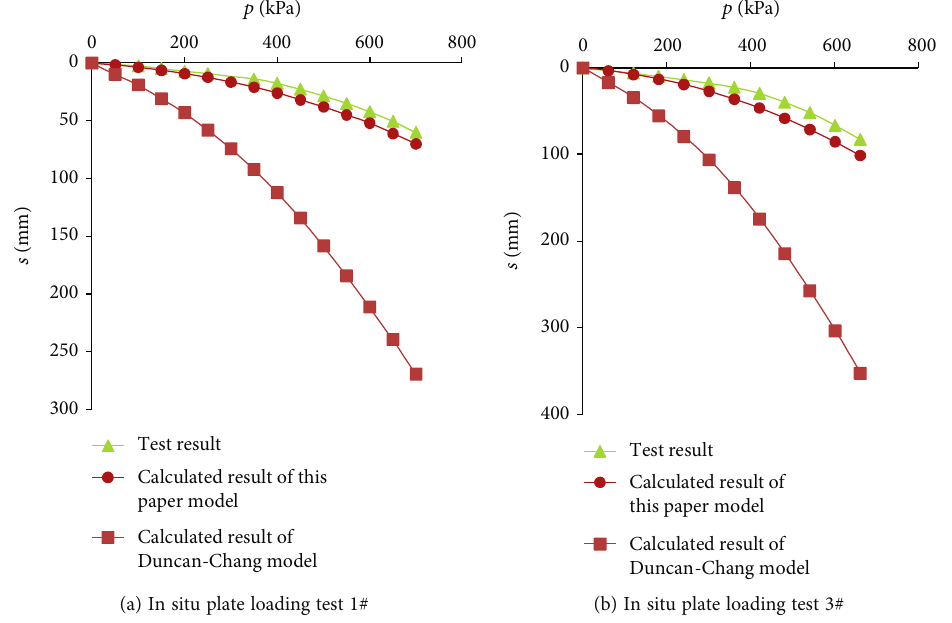
Figure 6: Comparison of numerical results using the variable modulus constitutive model and in situ test results. Table 4: Calculated parameters of the Duncan-Chang